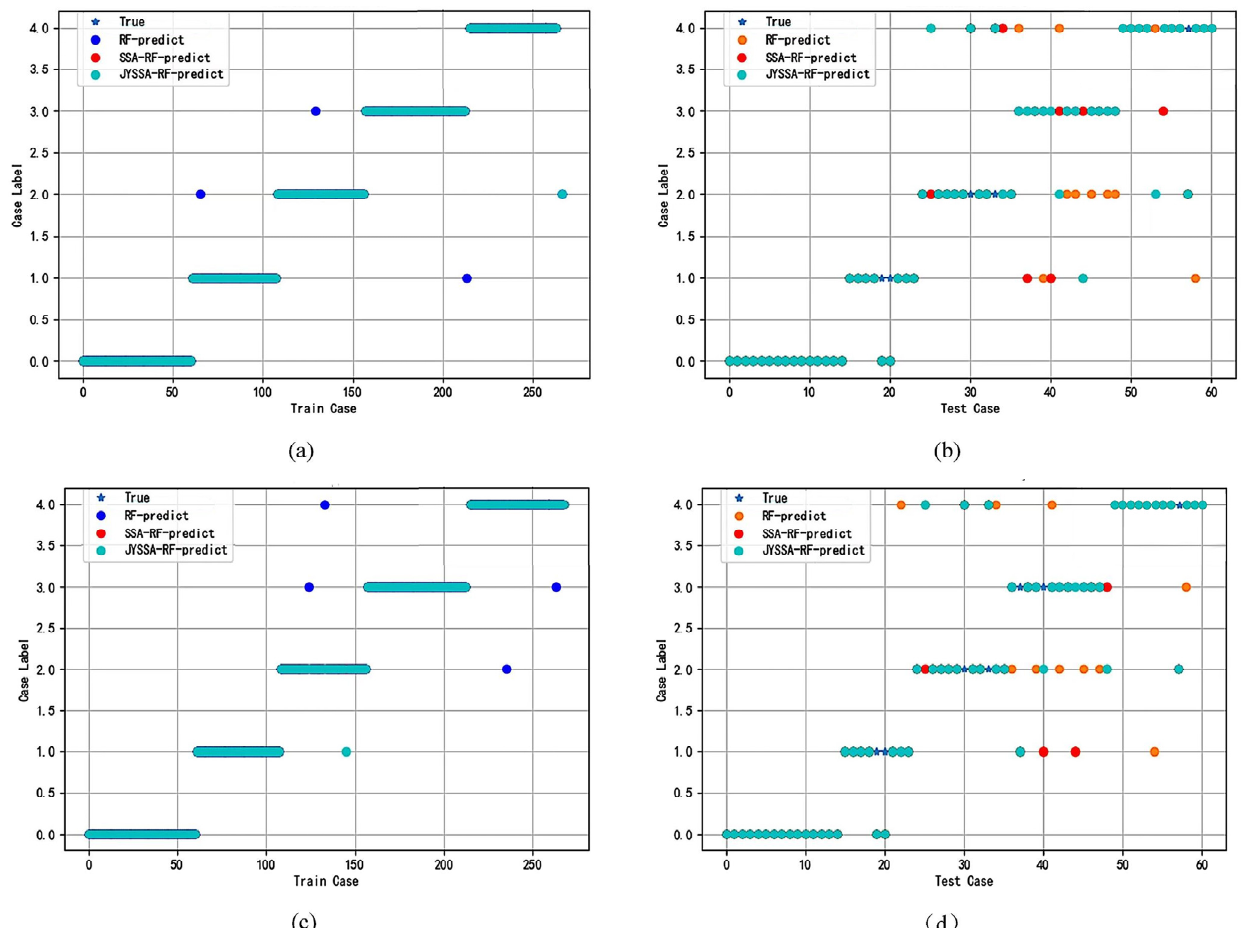
convergence curves of 186 bands. ( b )